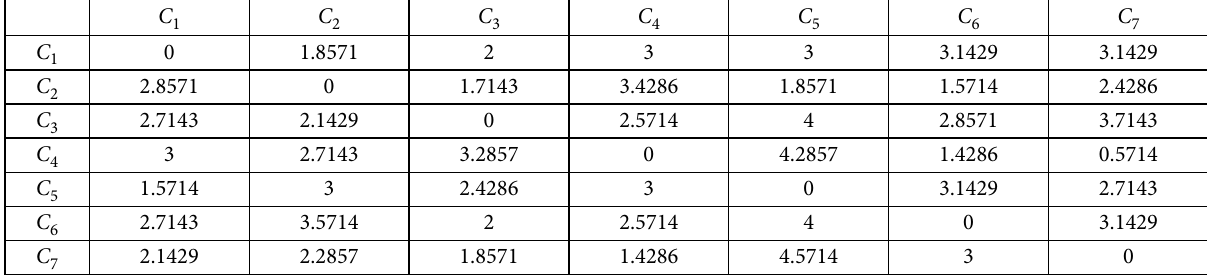
Table 3. The aggregated decision matrix for all decision